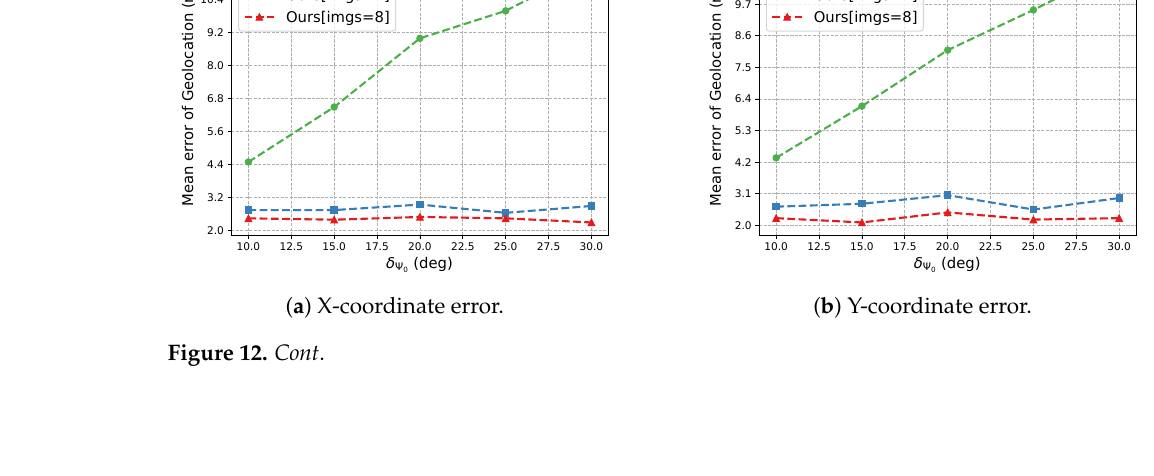
Figure 11. Geolocation errors under different measurement errors of attitude and position.